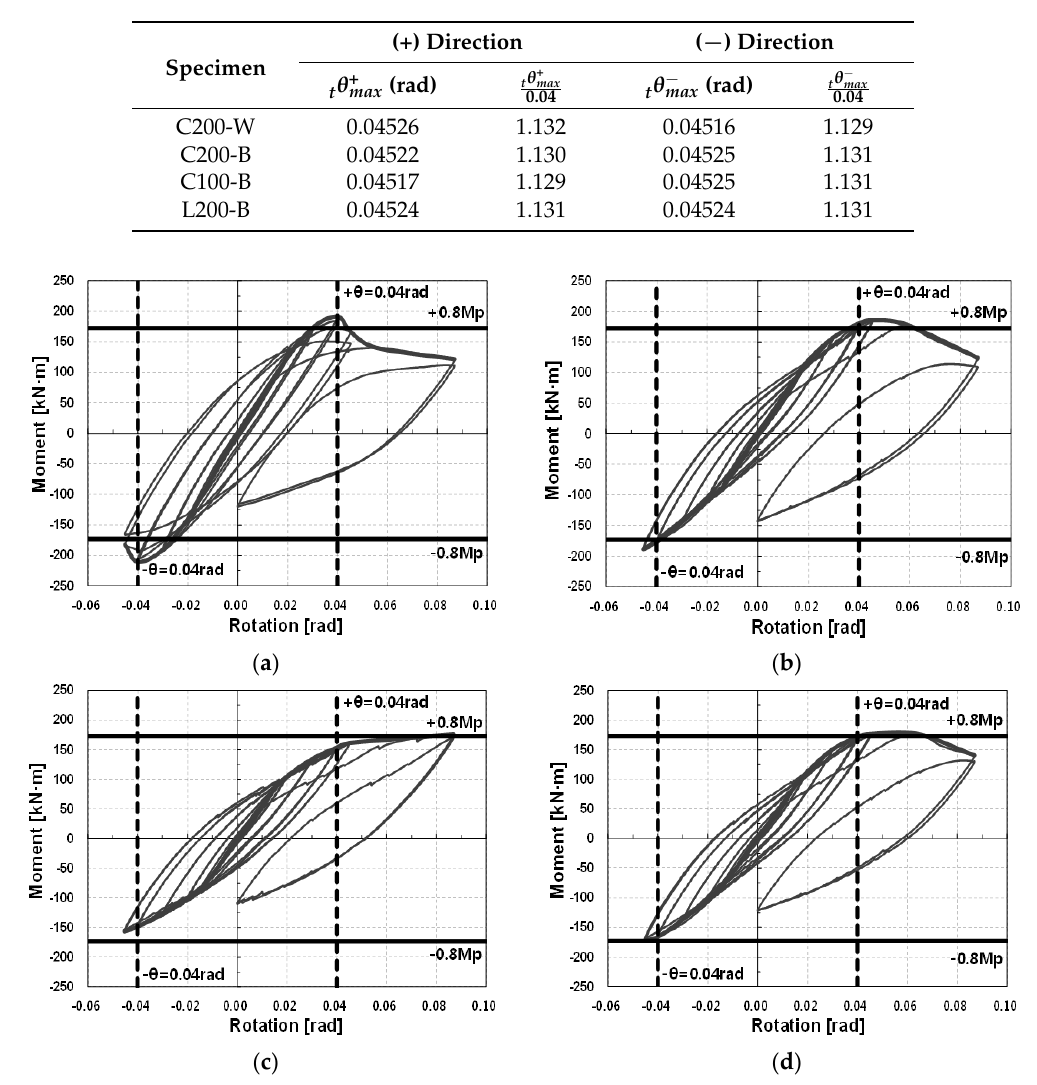
Table 12. Comparison of a drift angle for a special moment frame.